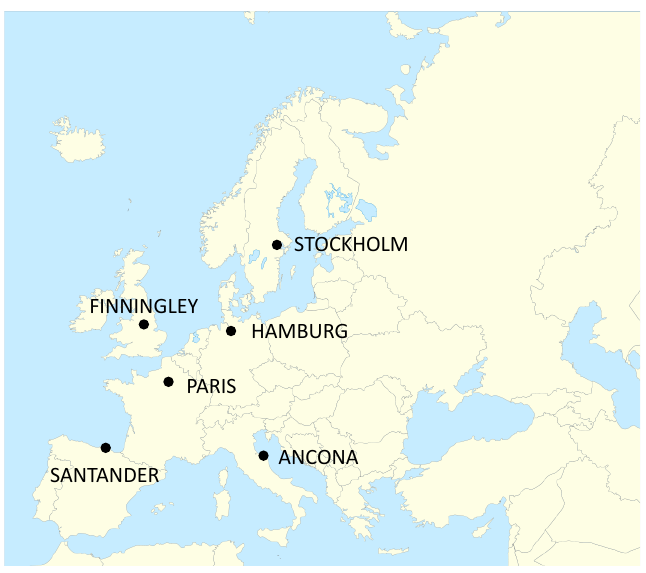
Figure 1. Geographic collocation of the selected cities.